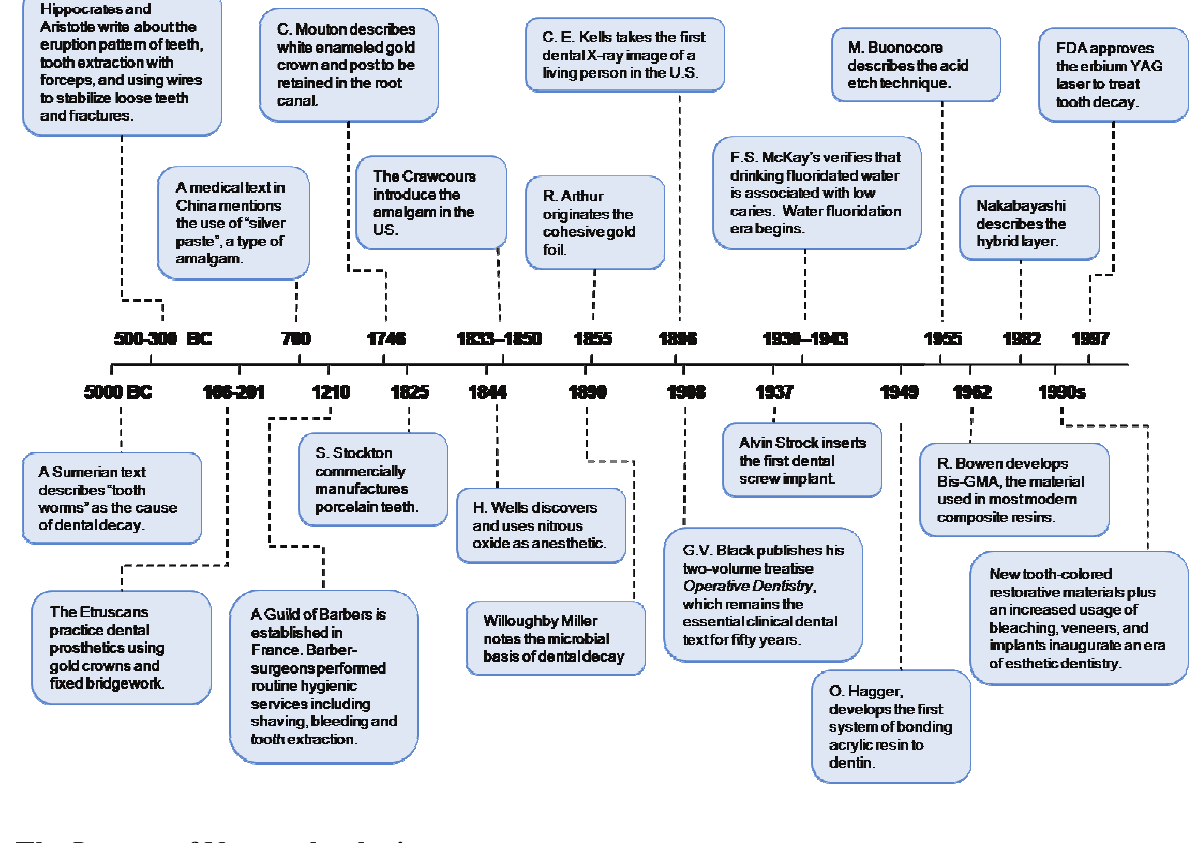
Figure 1. Dental Sciences, the shift from macro to nano (modified